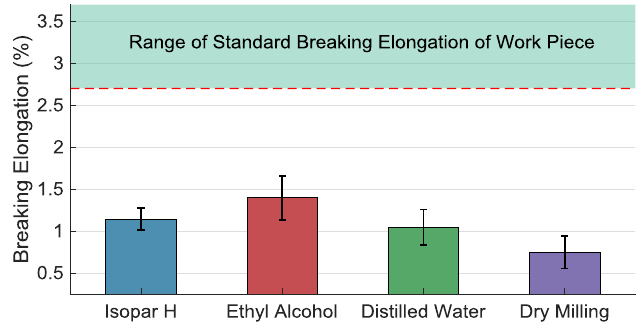
Figure 10. Breaking elongation of work piece micromilled under different coolants and methods.